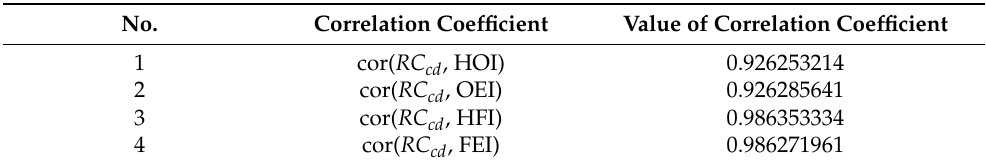
Table 7. The correlation coefficients of the RC cd (shape parameter) with HOI, OEI and HFI, FEI (demand energy parameters) of buildings belonging to